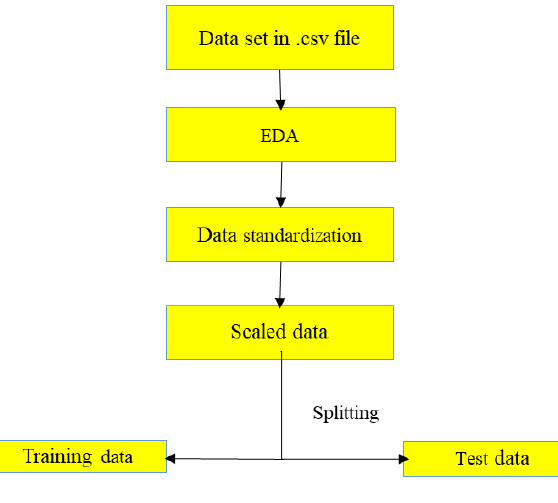
Figure 8. Data pre-processing.